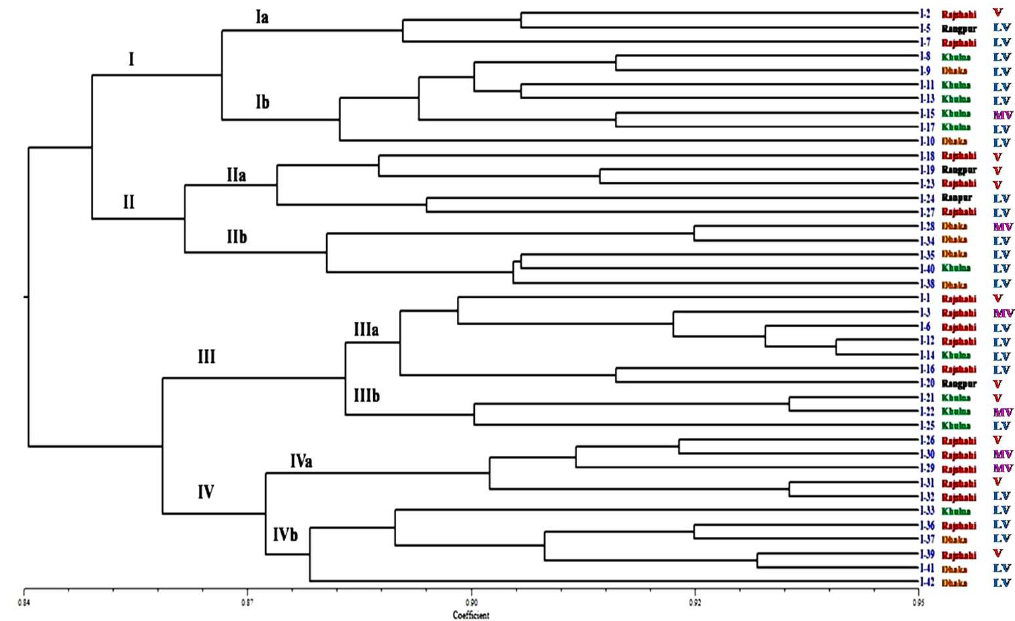
Figure 8. Dendrogram derived from UPGMA cluster showing the genetic relationships among the 41 C. falcatum isolates from four regions of Bangladesh. Note: Virulence level denoted as V = Virulent; MV = Moderately virulent and LV = Less Virulent.